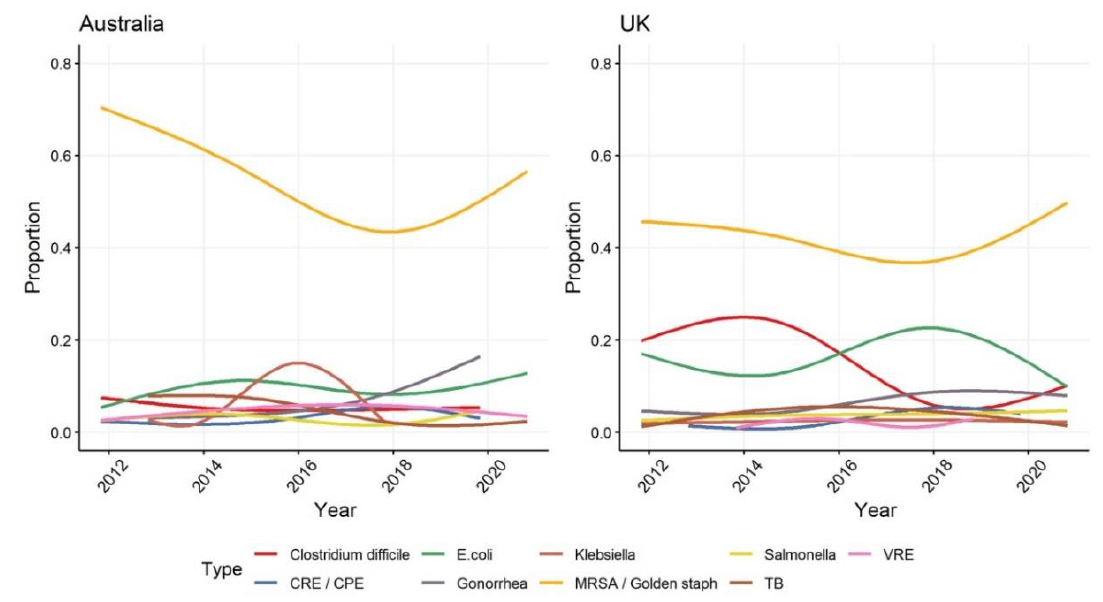
Figure 3. The nine most mentioned types of microbes in Australian and UK newspaper coverage about